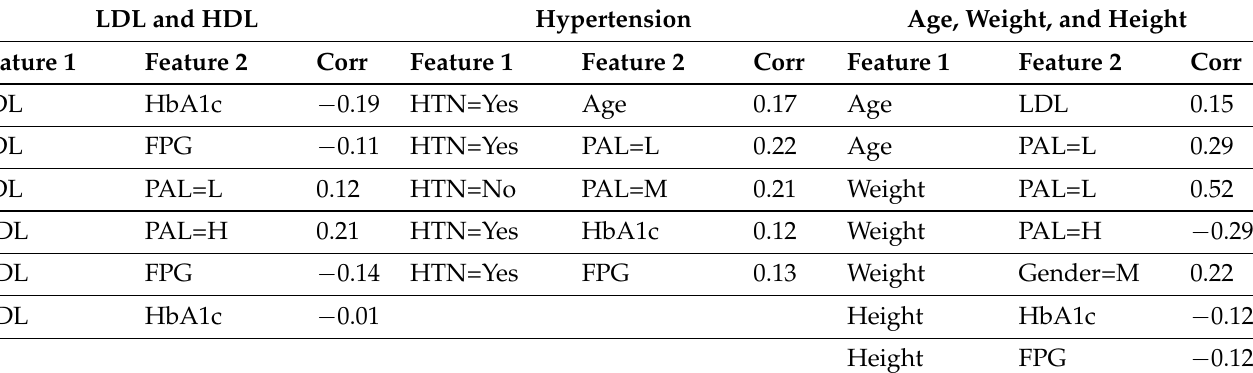
Table 4. Correlation between various features after